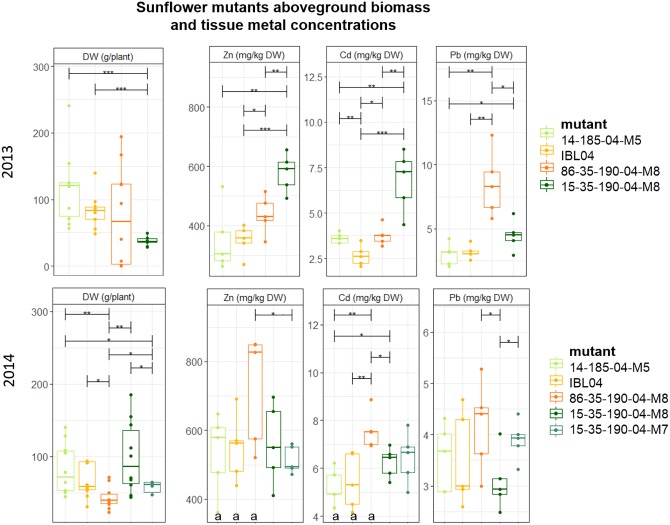
Mean aboveground DW production per plant (g) of sunflower mutants tested in 2013 and 2014. Error bars are SEs (n = 10). IBL04 is the mother line of all mutants. Stars represent significant differences at the level of p < 0.05 (∗), p < 0.01 (∗∗) and p < 0.001 (∗∗∗) between clones within a year (ANOVA, Tukey-HSD). Significant differences between the years for each clone are denoted with the letter a (p < 0.01, t-test).